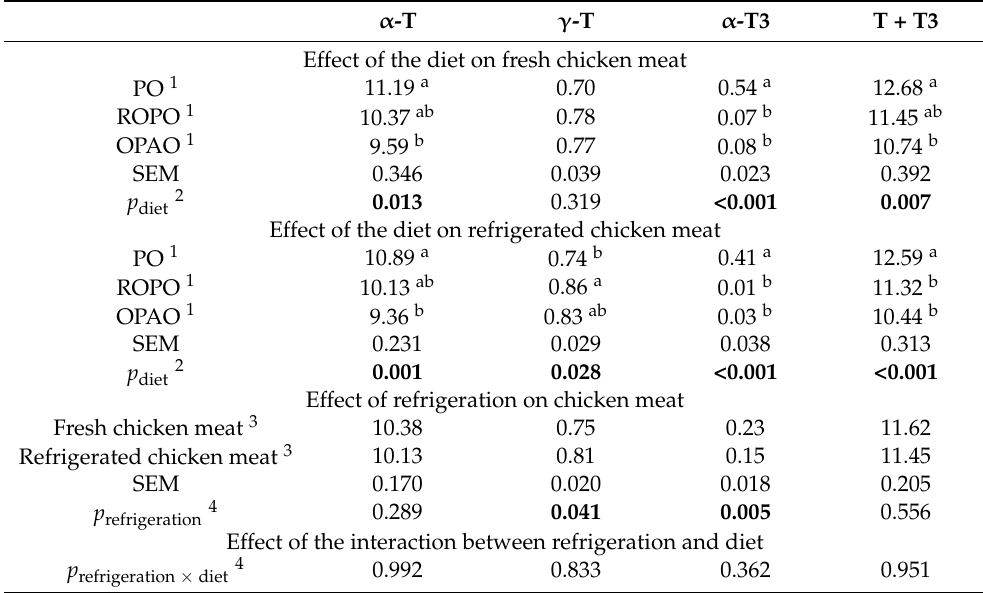
Table 5. Tocopherol and tocotrienol content (mg/kg) of fresh and refrigerated dark chicken meat with